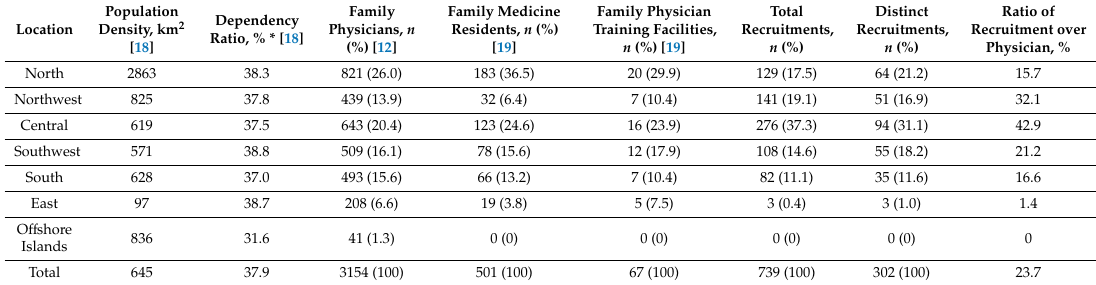
Table 1. Distribution of family physicians and recruitments by area in Taiwan.